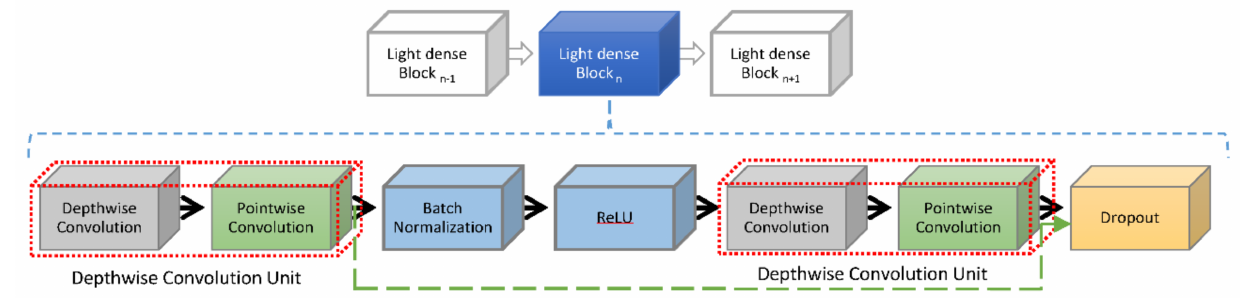
Figure 6. Proposed light dense